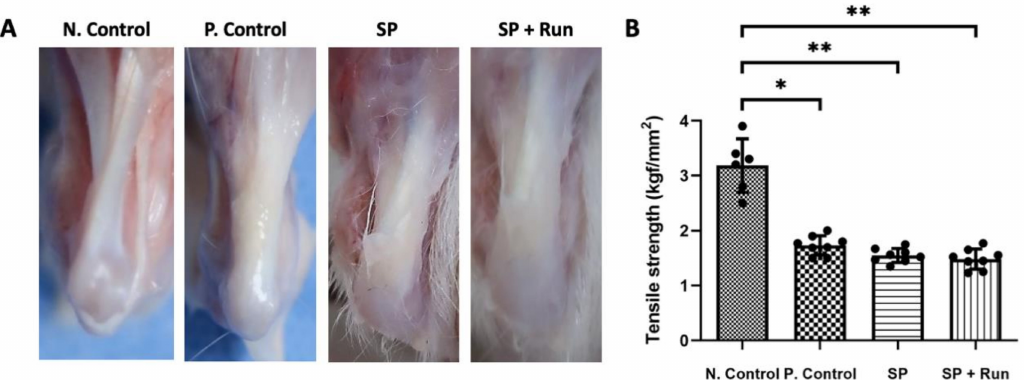
Figure 4. Gross phenotypes of the Achilles tendons and tensile strength of muscle-tendon-bone complex. The Negative (N.) Control tendon had a shiny smooth gross appearance in comparison to the others. However, the Positive (P.) Control, SP, and SP + Run groups showed dull and thicker tendons with a yellowish hue. In particular, SP + Run group showed the most severe change ( A ). Biomechanical testing was used to compare the tensile strength among Control, SP with treadmill running, SP, and SP + Run groups. Both SP and SP + Run groups had significantly lower tensile strength compared to the N. Control, similar to the P. Control. Data are represented as mean ± standard deviation. Kruskal–Wallis test with Tukey’s post-hoc test was used for statistical evaluation. n = 6 (N. control), n = 8 (P. control, SP, SP + Run). * p < 0.05 and ** p < 0.01. Scattered dots are used to show variables. ( B